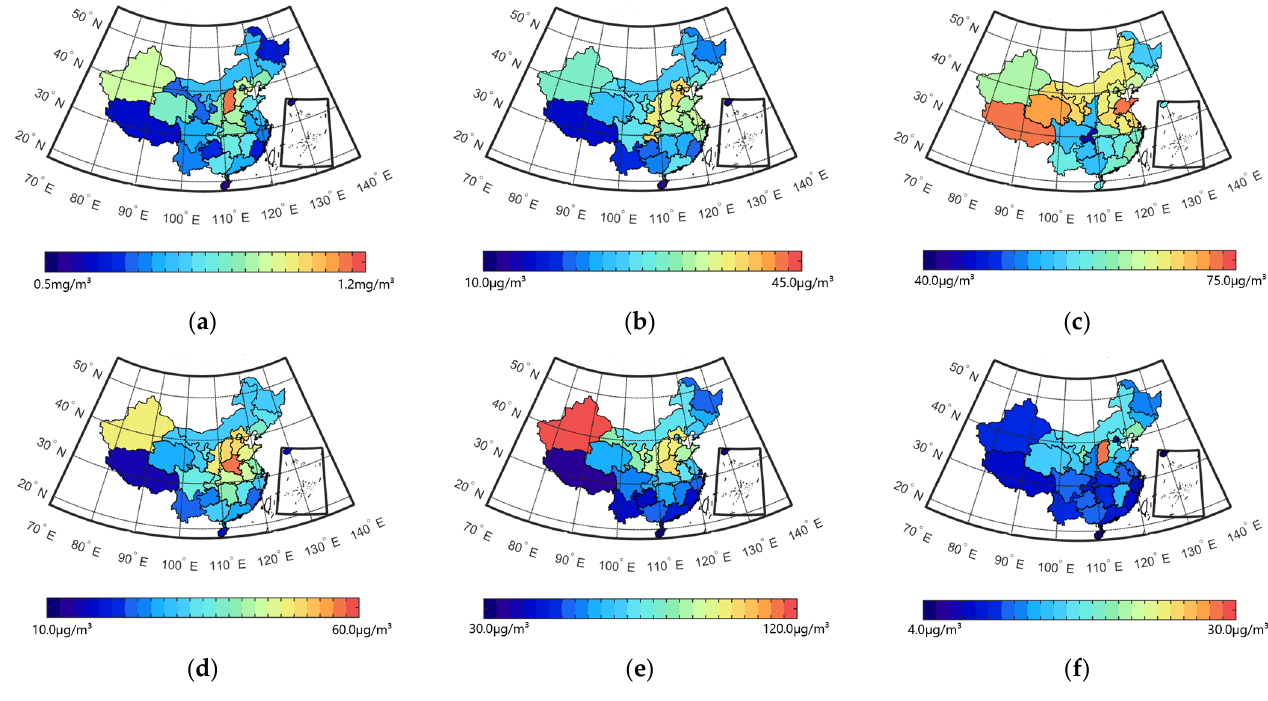
Figure 3. Average concentrations of air pollutants during 2017–2021 in 31 PARs: ( a ) CO; ( b ) NO 2 ; ( c ) O 3 ; ( d ) PM 2.5 ; ( e ) PM 10 ; ( f ) SO 2 .